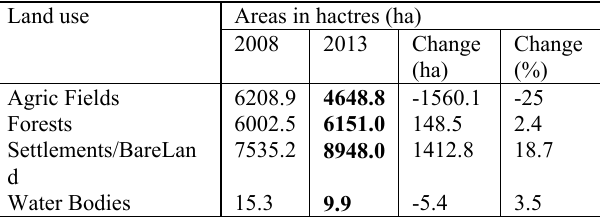
Figure 2. Land Cover Map